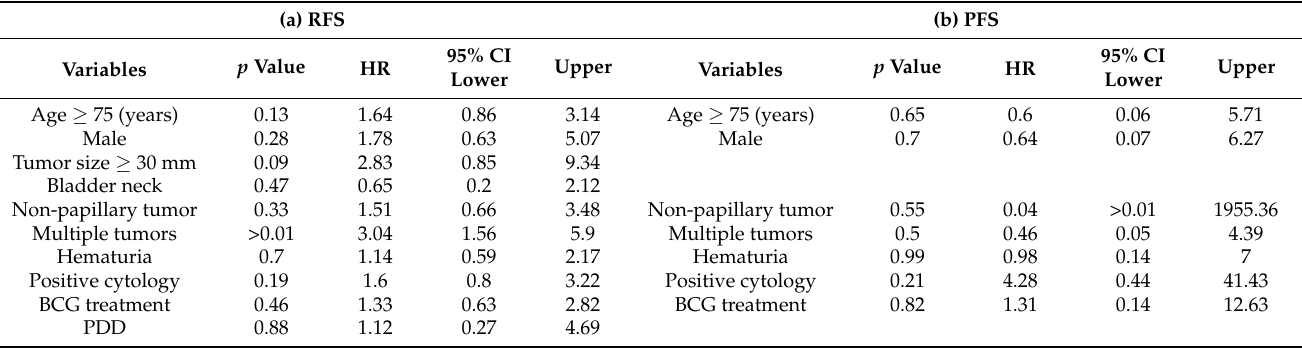
Table 5. Univariate analysis of the prognostic factors for recurrence-free survival and progression-free survival of patients with NMIBC with negative inchworm